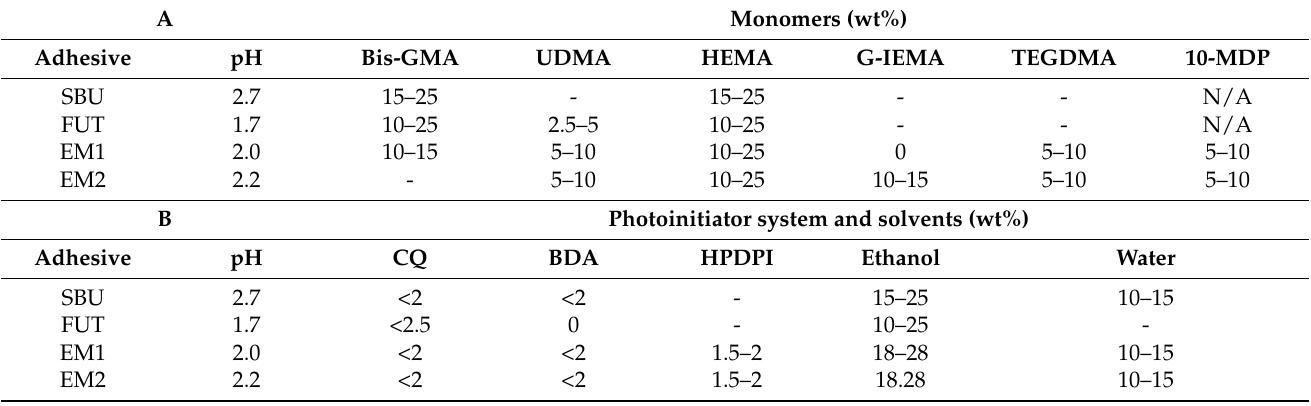
Table 1. ( A ). Relative percentage of components according to information derived from manufactur- ers’ and safety datasheets. EM1/EM2 formulations were also taken from Vasconcelos e Cruz et al. (2020), which shows the relative percentage of monomers (wt%), while Table B shows the photoinitia- tor system and the solvents in wt%. ( B ). Table shows the wt% of the components in the photoinitiator system and the solvents present in